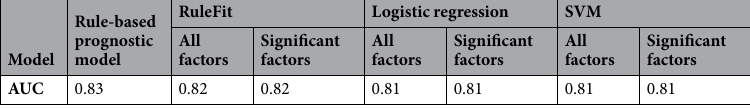
Table 3. Prediction accuracy of several methods on testing data.